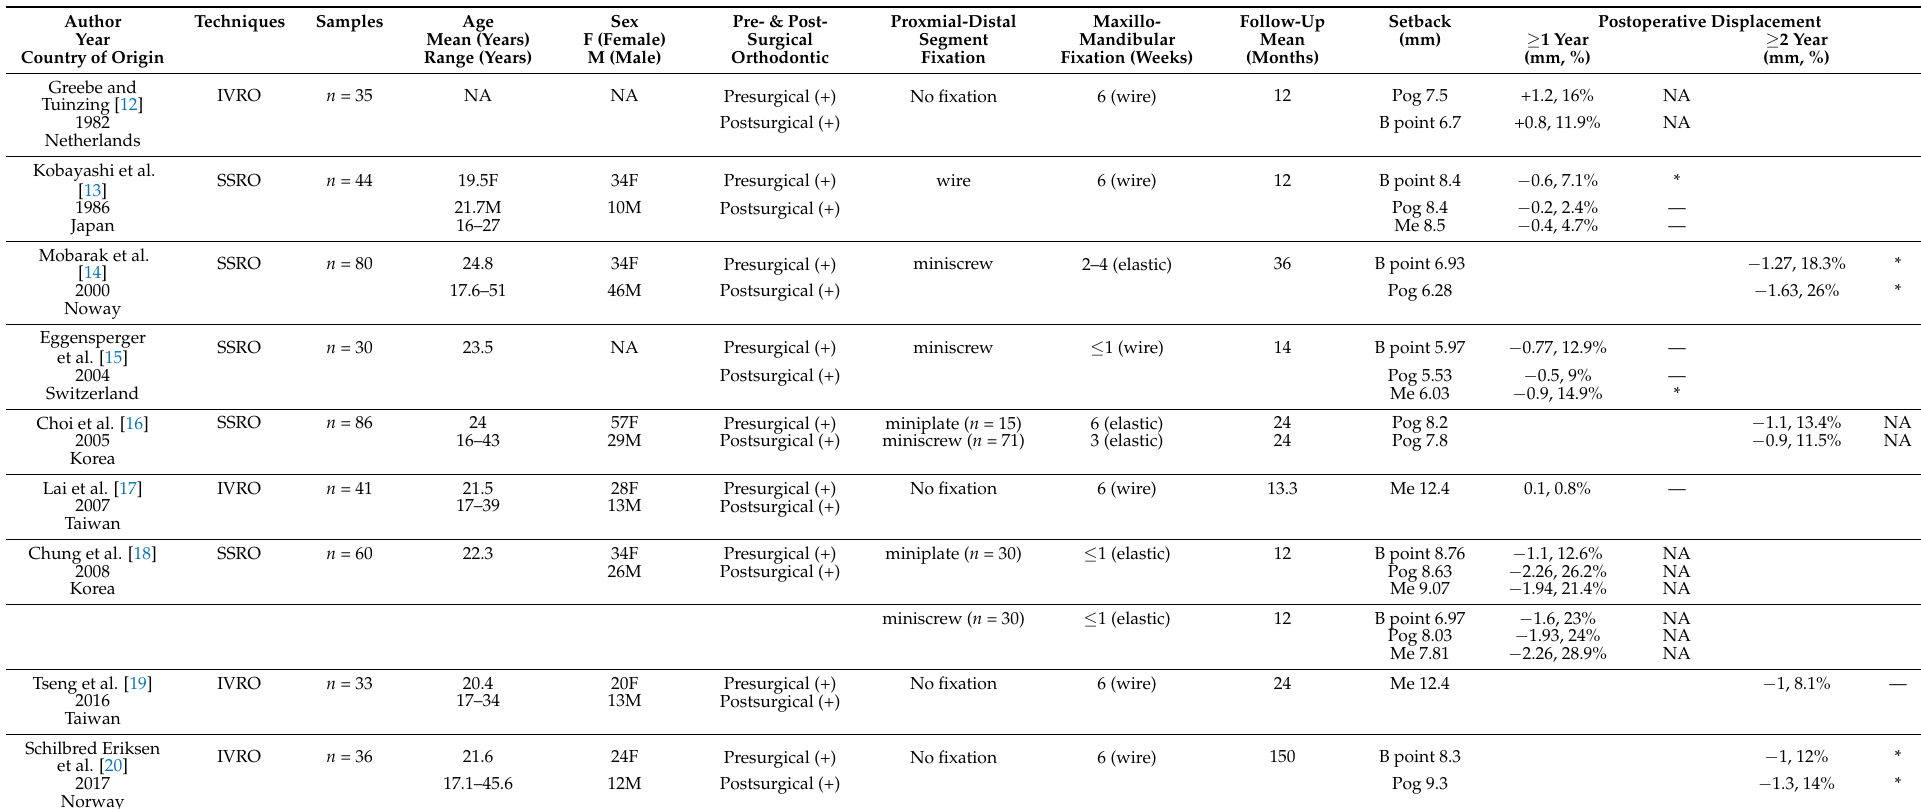
Table 1. Demographic and study characteristics in the included